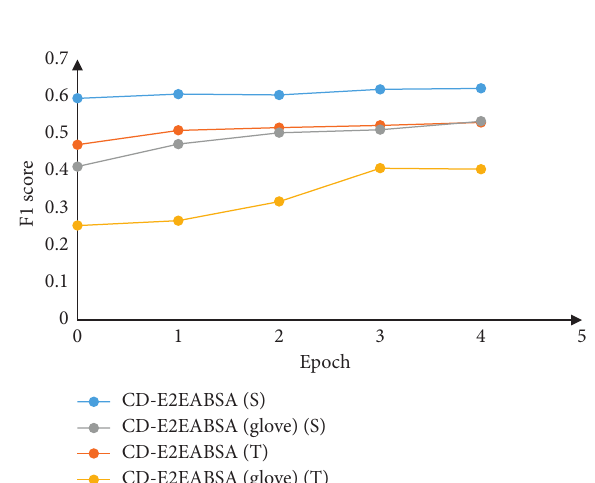
Figure 6: The change of F1 scores using the word embedding layer and glove embeddings in CD-E2EABSA after 4 epochs. (i) CD- E2EABSA (S) uses Bert as the embedding layer for thw source domain; (ii) CD-E2EABSA (T) uses Bert as the embedding layer for the target domain; (iii) CD-E2EABSA (Glove) (S) uses glove embedding as input for the source domain; and (iv) CD-E2EABSA (Glove) (T) uses glove embedding as input for the target domain.